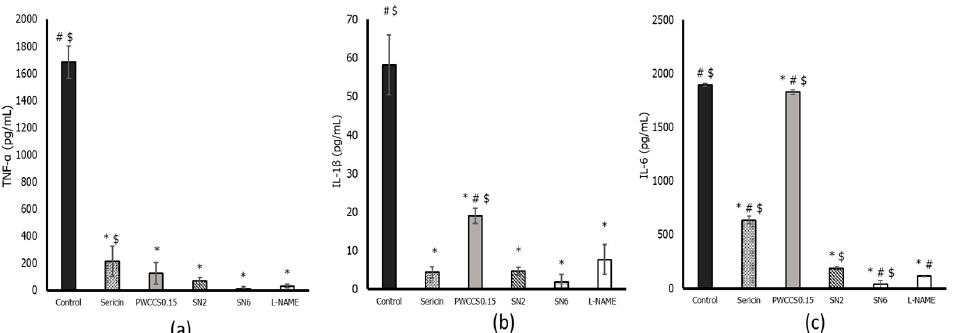
Figure 4. Inflammatory cytokine levels of TNF- α ( a ), IL-1 β ( b ), and IL-6 ( c ) in LPS-stimulated RAW 264.7 cells. Data represent the mean ± SEM of three replicates. Statistical significance was evaluated by Dunnett post-hoc test, * p < 0.05 compared with control (LPS-treated group), # p < 0.05 compared with SN2 and $ p < 0.05 compared with L-NAME.